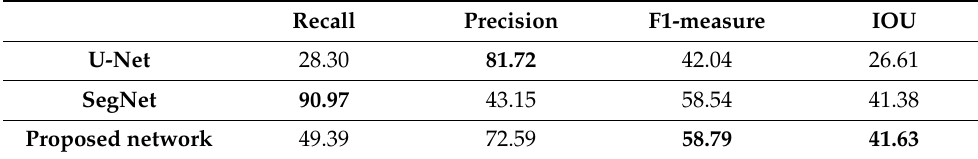
Table 5. Evaluation statistics (%) in landslide detection from Taiwan study